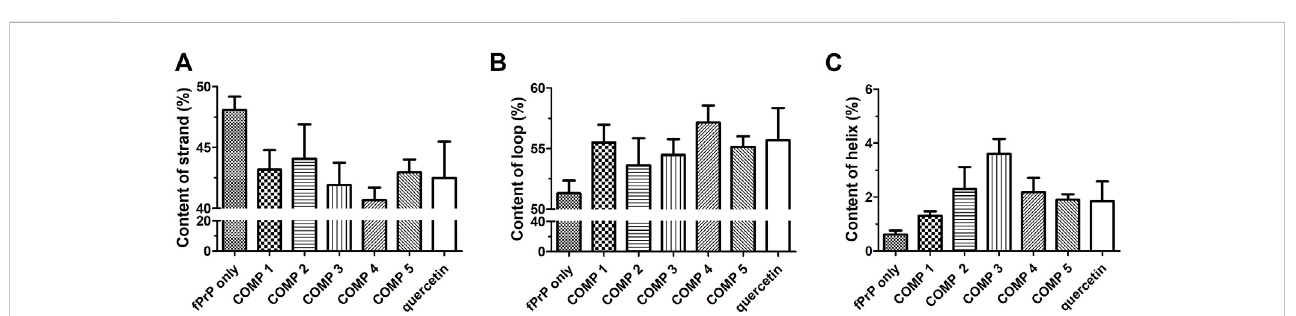
FIGURE 7 DSSP analysis of the secondary structure contents of (A) strand, (B) loop, and (C) helix in ligand-fPrP 170 – 229 ( n =